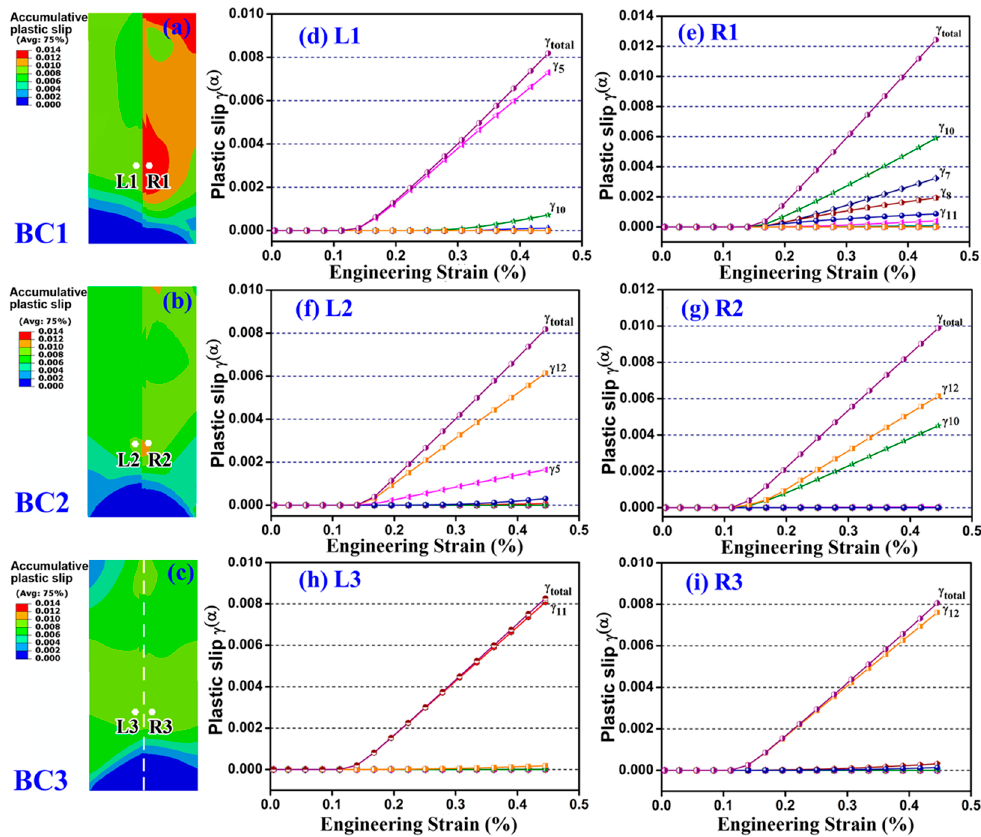
Figure 3. ( a – c ) Field of accumulative plastic slip on the longitudinal section of BC1, BC2 and BC3, respectively, after 0.4% strain. L1 ( d ), R1 ( e ), L2 ( f ), R2 ( g ), L3 ( h ) and R3 ( i ).